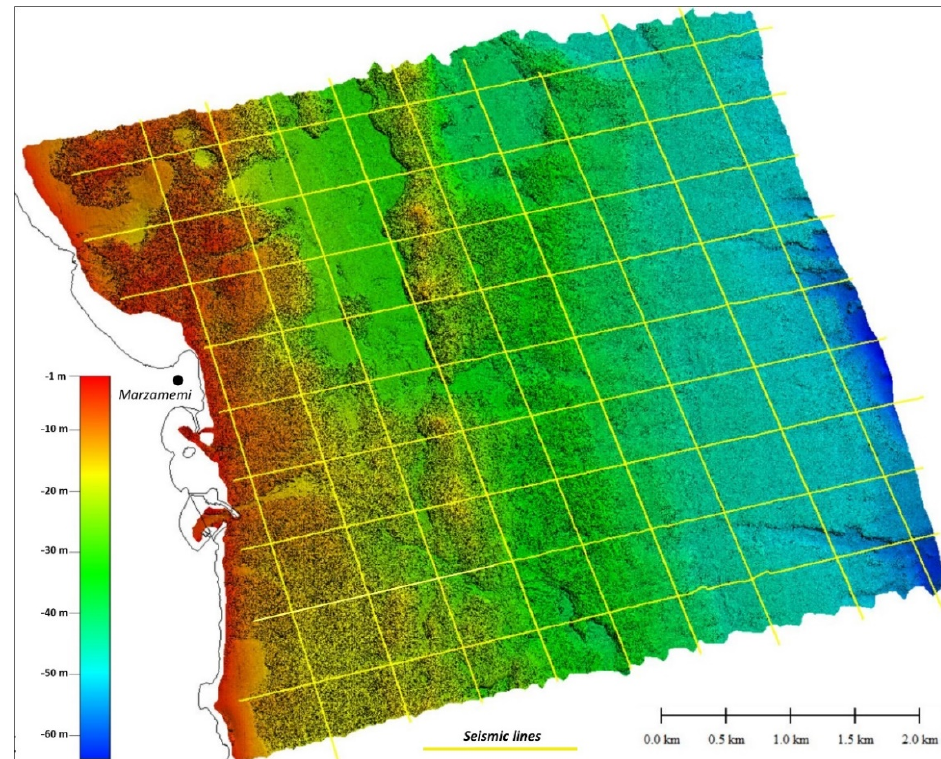
Figure 3. Overlapping of the datasets analyzed for the geomorphological reconstruction of the Marzamemi offshore: the bathymetric data (Multibeam) and the grid of seismic profiles (Sparker).